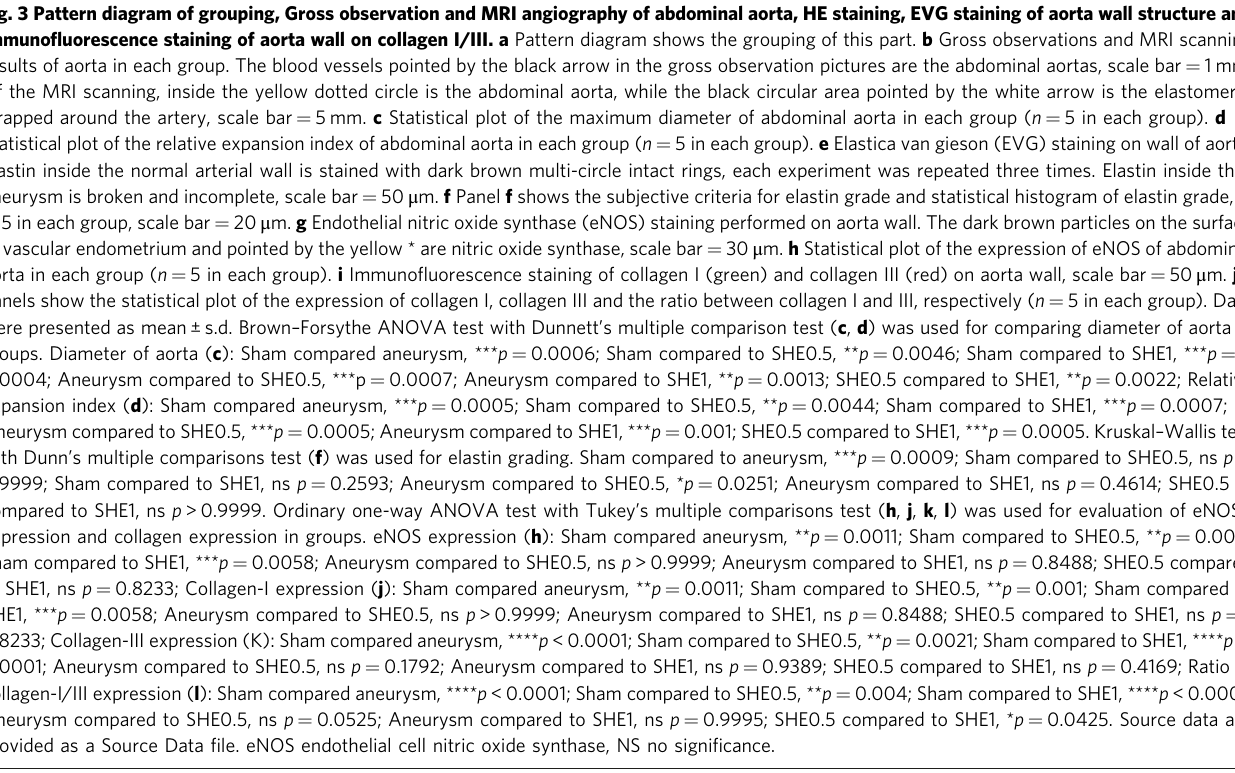
neurons in the SHE0.2 group was higher than that in the suture, fi brin-glue and PCL-conduit groups, and there was no signi fi cant